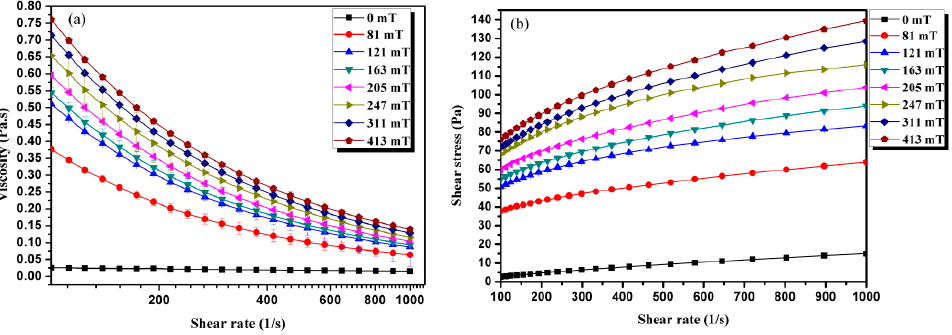
Figure 6. The viscosity of MF as a function of shear rates ( a ); shear stress vs. shear rate curves ( b ).